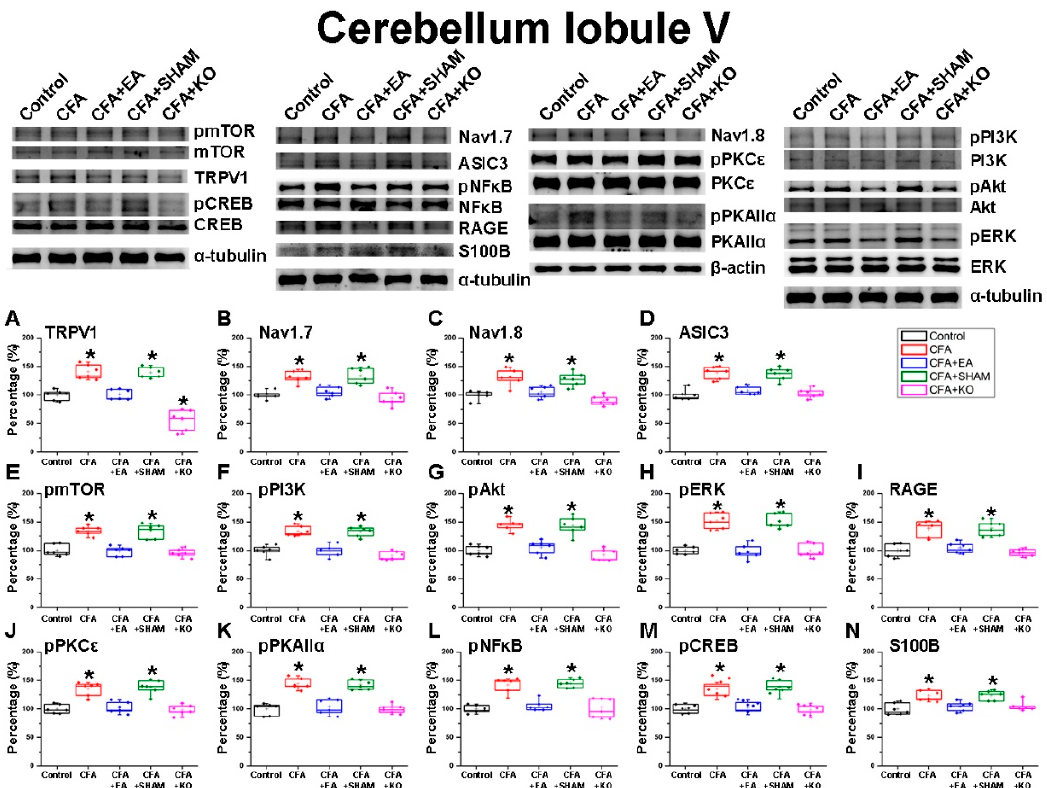
Figure 2. The expression levels of pain receptors and involved molecules in the cerebellum lobule V. The immunoblotting images contain five lanes of protein in the following order: control, CFA, CFA + EA, CFA + SHAM, and CFA + KO groups. There are significant decreases of ( A ) TRPV1, ( B )